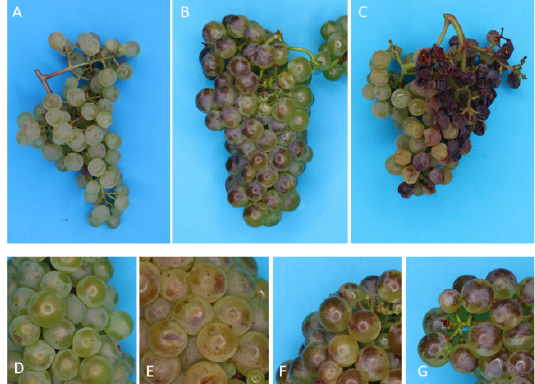
Figure 5. Bunches exhibiting varying degrees of sunburn damage. Above: Bunches exhibiting no damage ( A ), sunburn browning ( B ) and sunburn necrosis ( C ). Below: varying degrees of sunburn browning: ( D ) SB0, ( E ) SB1, ( F ) SB2 and ( G ) SB3.